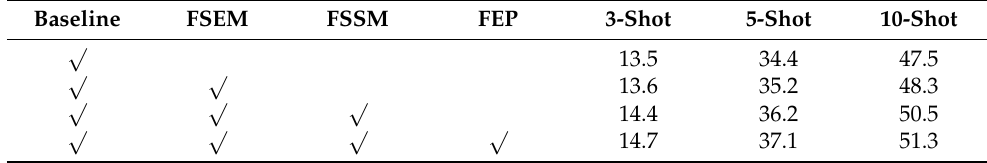
Table 2. Ablation experiment